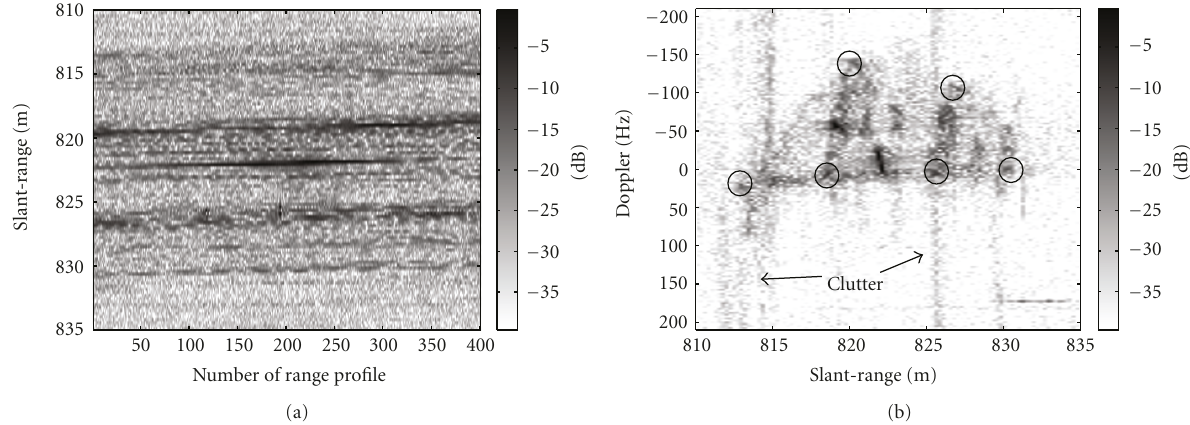
Figure 9: (a) Range profiles and (b) ISAR image for the real data of the two-mast sailboat. No motion compensation technique has been applied.